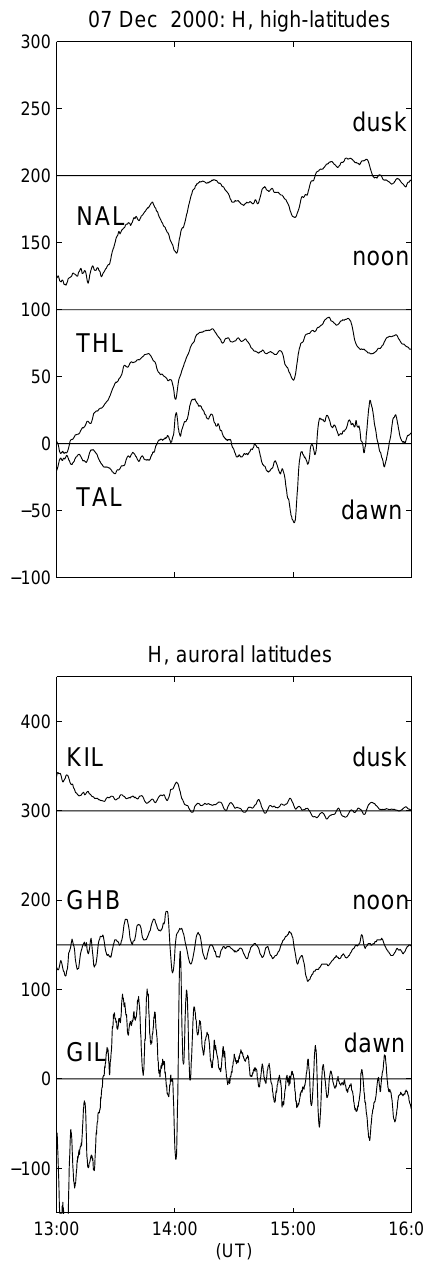
Fig. 2. Magnetograms (magnetic north component) from stations of IMAGE (NAL and KIL), CANOPUS (TAL and GIL) and Green- land (GHB and THL)